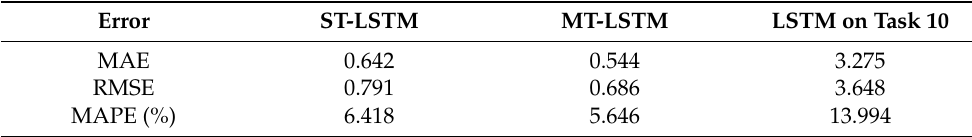
Table 7. Error results of MT-LSTM, ST-LSTM, and LSTM for the extreme